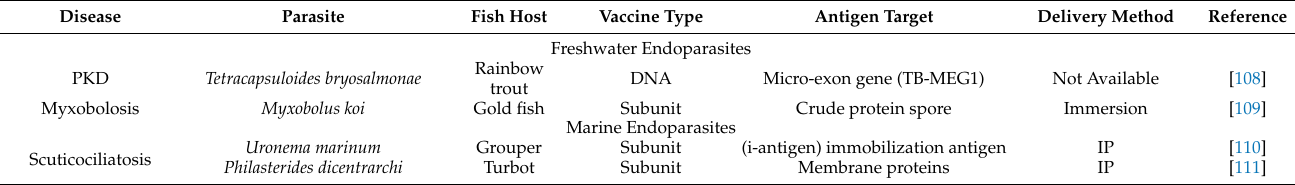
Table 3. Overview of immunization trials in fish against parasites: Table provides information on immunization trials for important endoparasites. NA: Not Available, IM: Intramuscular, IP: Intraperitoneal.